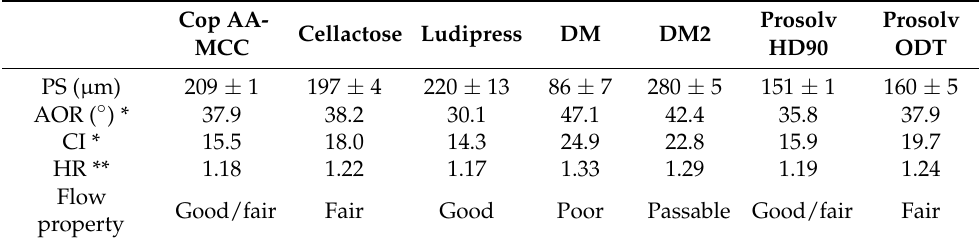
Flow Good/fair Fair Good Poor Passable Good/fair property